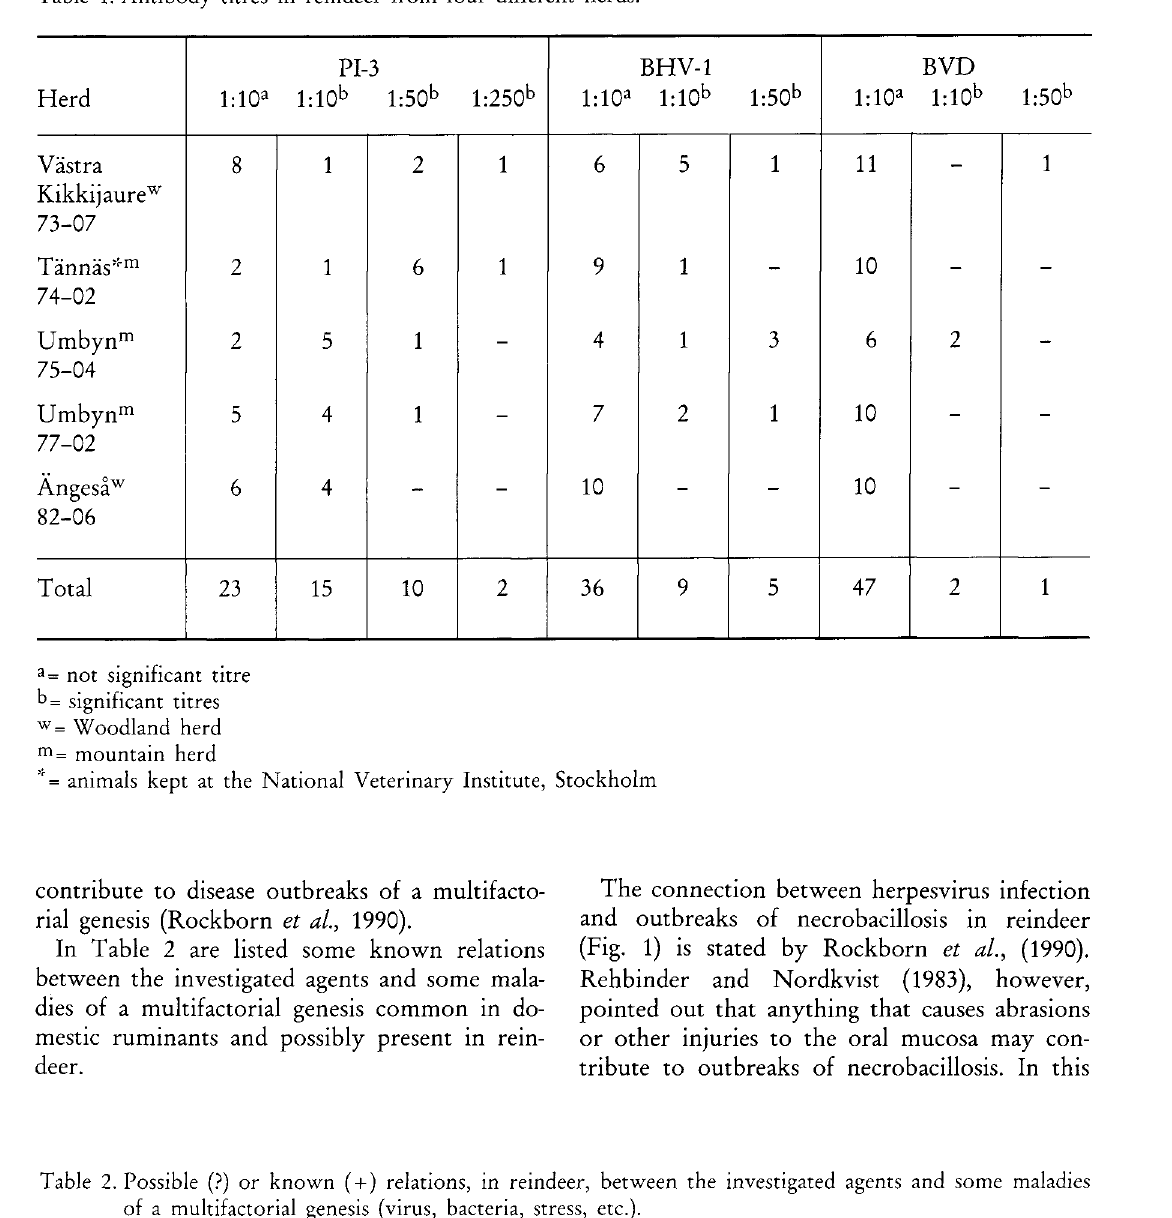
Table 2. Possible (?) or known ( + ) relations, in reindeer, between the investigated agents and some maladies of a multifactorial genesis (virus, bacteria, stress,